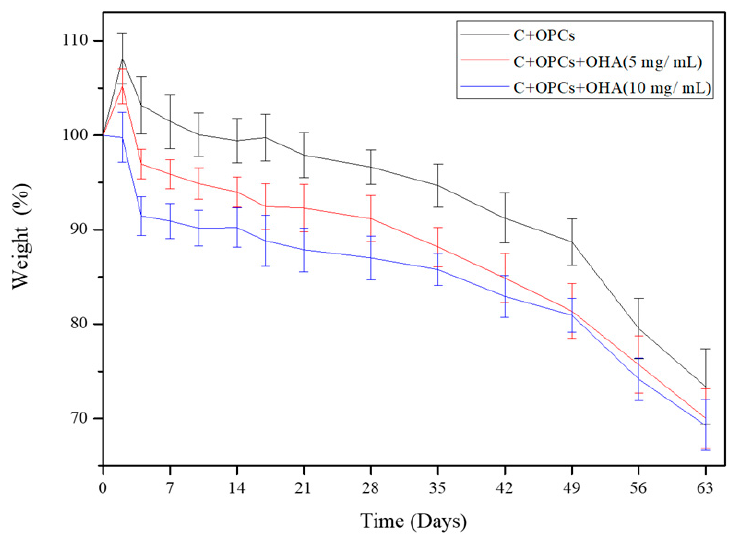
Figure 6. Degradation behavior of collagen-based scaffolds with different OHA concentrations in PBS solution at different time intervals. PBS solution at different time